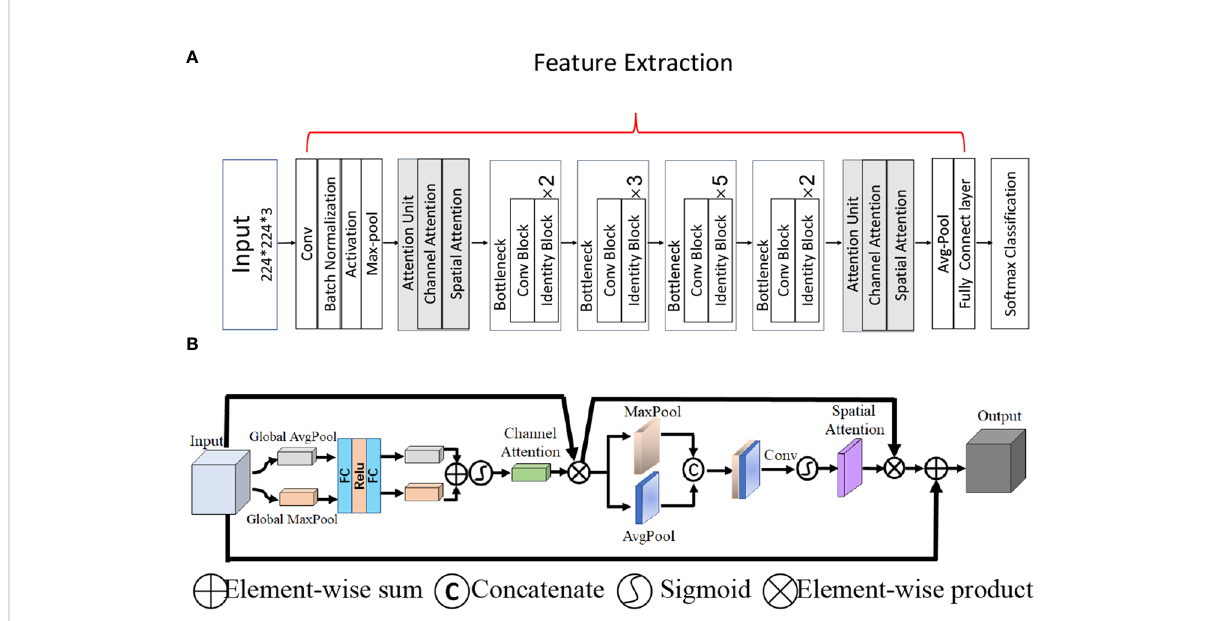
FIGURE 3 The overall network architecture. (A) Architecture of the backbone network ResNet-50 with two attention units. (B) The attention